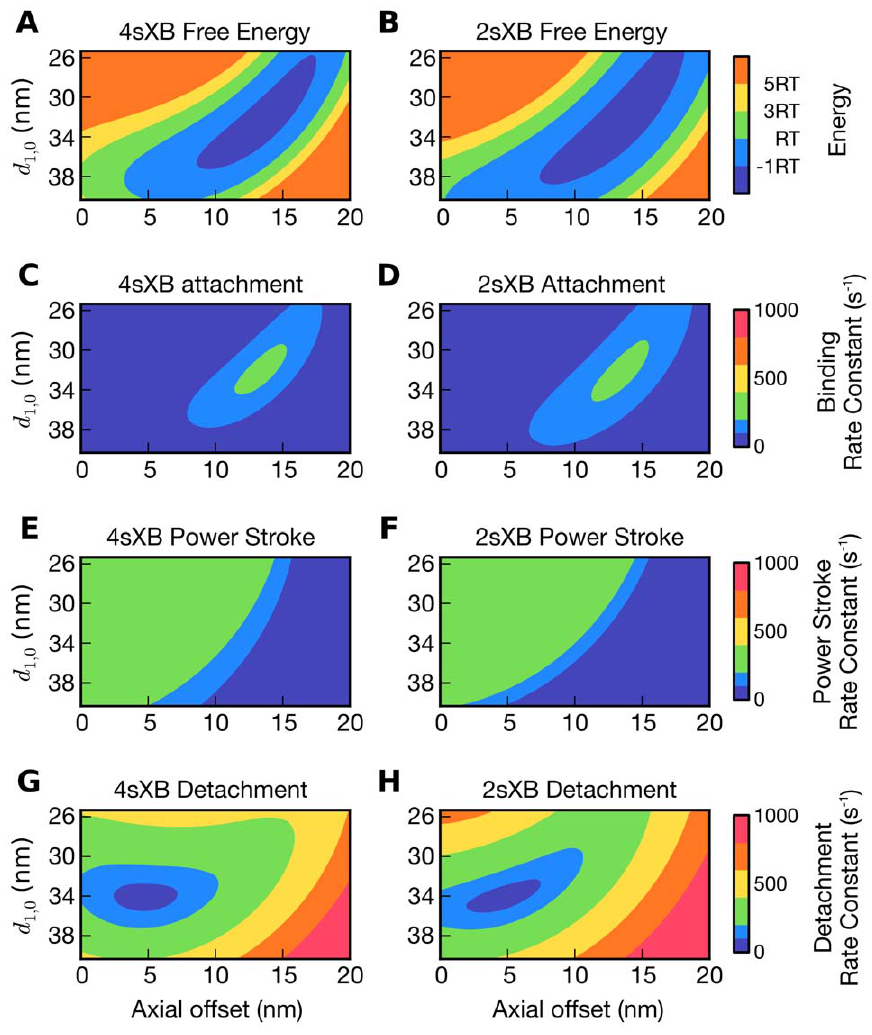
Figure 3. Energy and kinetics of the multi-spring cross-bridge models change with axial offset and lattice spacing. Axial offset is the distance between the current axial location of the cross-bridge tip and the location where the cross-bridge attaches to the thick filament. Lattice spacing ( d 10 ) is defined as in Millman (1998) [3], with an offset to account for filament thicknesses so the cross-bridge spans the filaments at a rest lattice spacing of 34 nm. (A)–(H) The properties of the 4sXB model (A, C, E, and G) and the 2sXB model (B, D, F, and H) as they change with binding site offset and lattice spacing. (A) depicts the free energy of the 4sXB model at various lattice spacings, with the head stretched to an axial offset from the thick filament attachment point. The free energy of the 2sXB model is shown in (B). (C) and (D) show r 12 , the probability that the 4sXB and 2sXB models will transition from an unbound state to a bound state. (E) and (F) show r 23 , the probability of transition from a pre-power stroke state to a post-power stroke state, for the same cross-bridges, axes, and scales as (C) and (D) show r 12 . (G) and (H) show r 31 , the probability of unbinding from a post-power stroke state. The reverse rate constants, r 21 , r 32 , and r 13 are back-calculated from the forward rate constants.